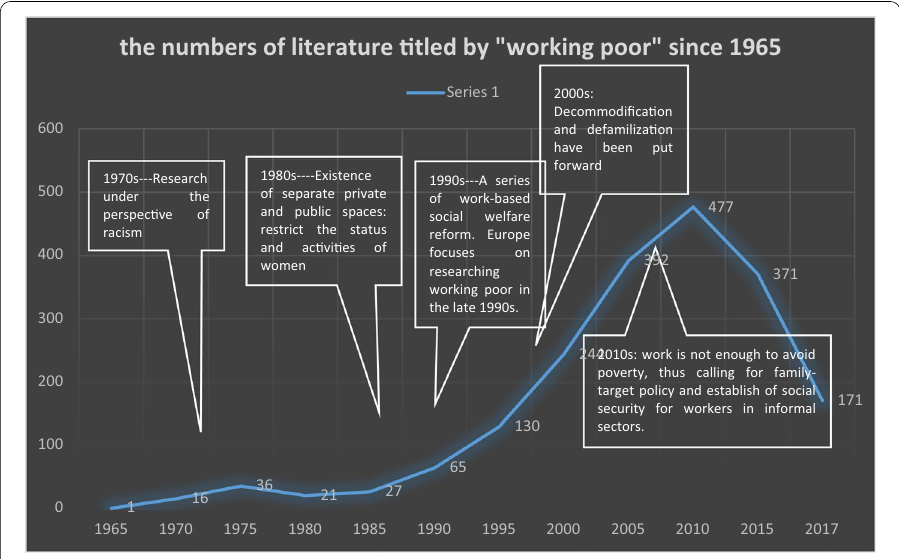
Fig. 1 Working poor research in